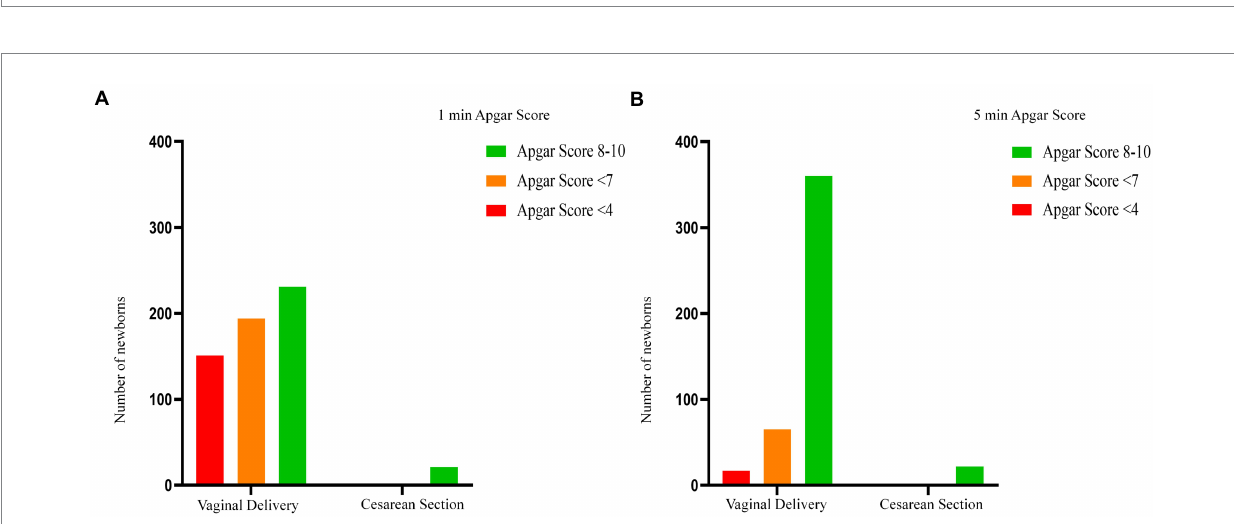
FIGURE 5 Apgar score between two modes of breech delivery. This compared the one-minute and five-minute Apgar score in the planned vaginal delivery group with that in the planned cesarean section group. The number of Apgar scores <7 at 1 min in vaginal delivery infants was significantly higher than that in cesarean section group ( p < 0.01). The same difference between the two groups was not statistically significant at 5 min ( p = 0.096). In the cesarean section group, there were no infants with Apgar score <7 in 5 min. A represents the difference in 1-minute Apgar score between the cesarean section group and the vaginal delivery group; and B represents the 5-minute Apgar score difference between the two